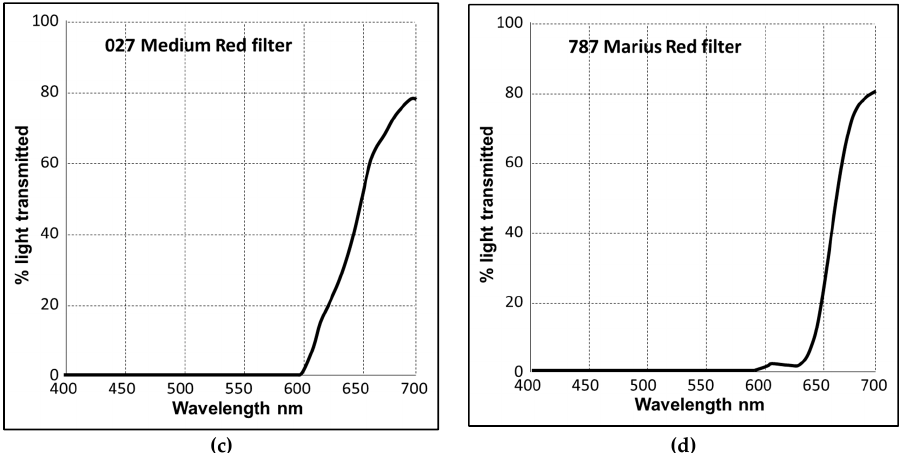
Figure A1. ( a ) Typical relative spectral power distribution of white, blue and red LED lights in the Algem bioreactor; ( b – d ) The light transmission (Y%) for each wavelength (nm) of filters that were used to transmit red light. ( b ) Lee Filters 026 Bright red (Transmission 8.6%), ( c ) 027 Medium Red (Transmission 3.6%), ( d ) 787 Marius Red (Transmission 1.0%).